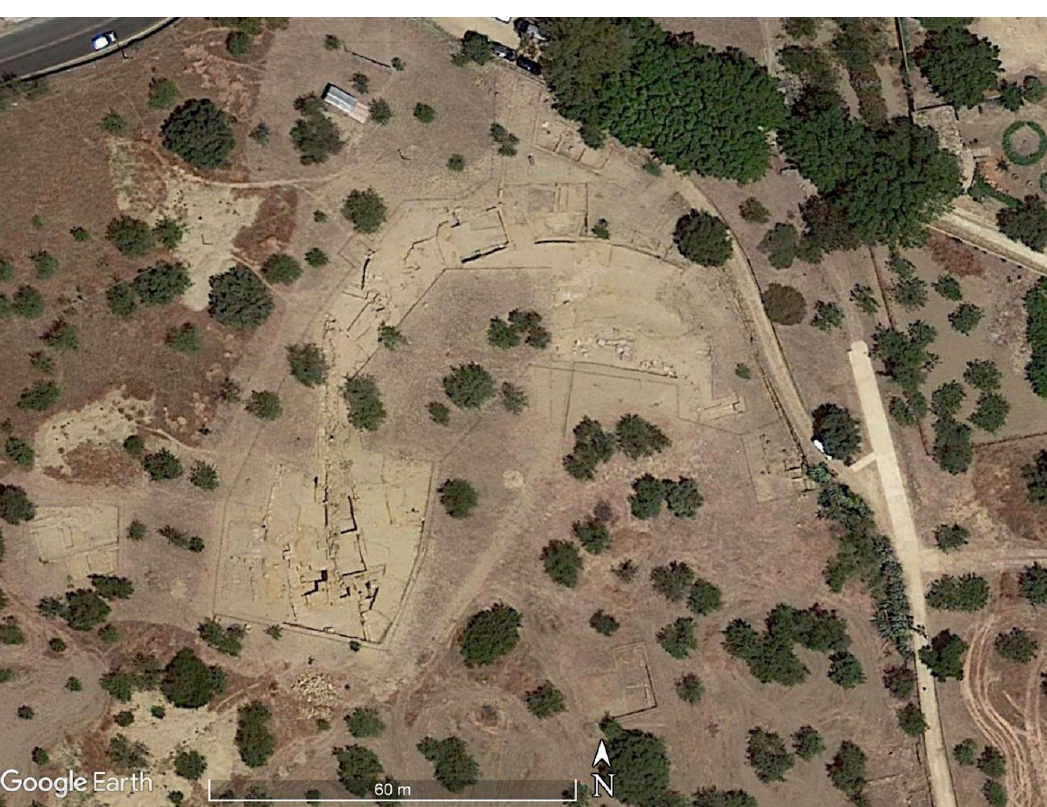
Figure 13. ERT 2, line 2 in Figures 3 and 11.